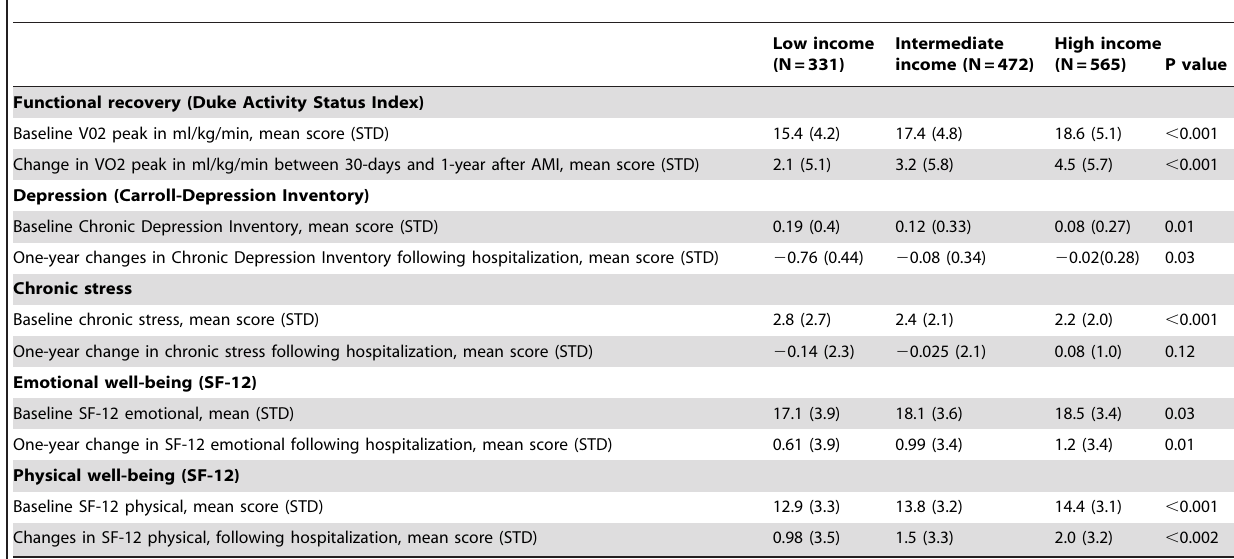
Table 2. Functional recovery, depression, psychosocial stress, emotional and physical well-being according to income tertile during the year following AMI hospitalization.